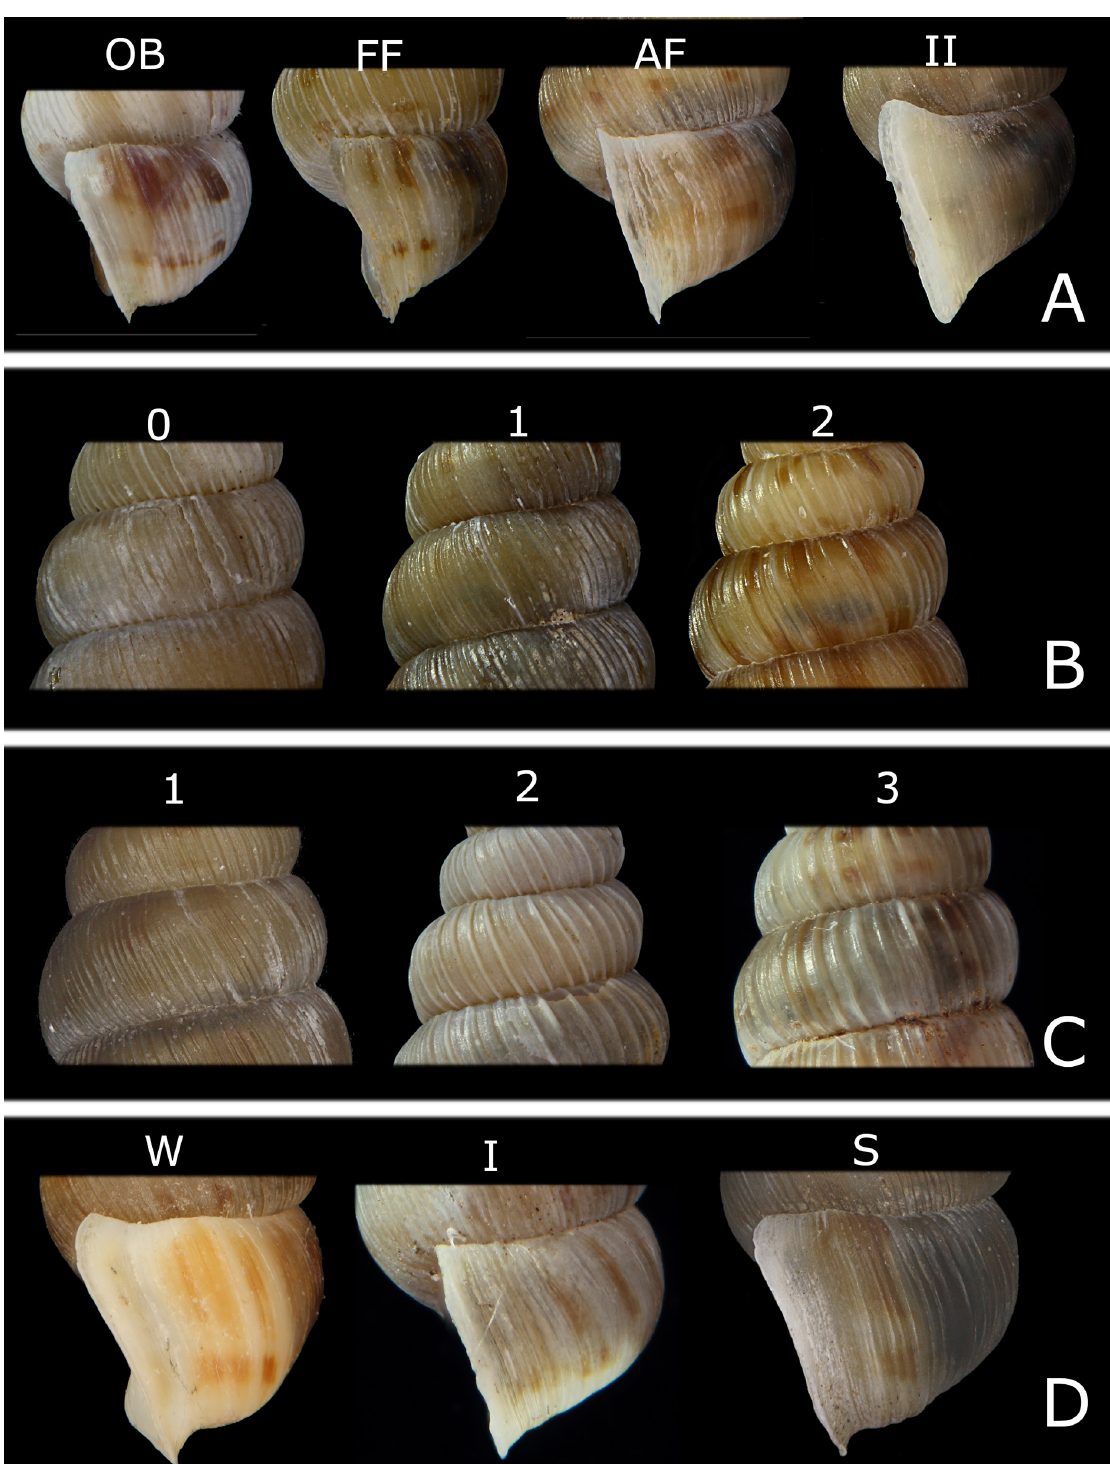
Fig. 4. Features of the shell of Clessiniella Zallot et al ., 2015. A . Shape of the body whorl approaching the aperture. B . Strength of the spots on the shell (0 = spotless shell to 2 = really evident spots). C . Strength of the ribs (1 = weak ribs to 3 = really prominent ribs). D . Strength of the ribs on the external side of the body whorl approaching the aperture (W= smooth shell; I = intermediate; S = prominent